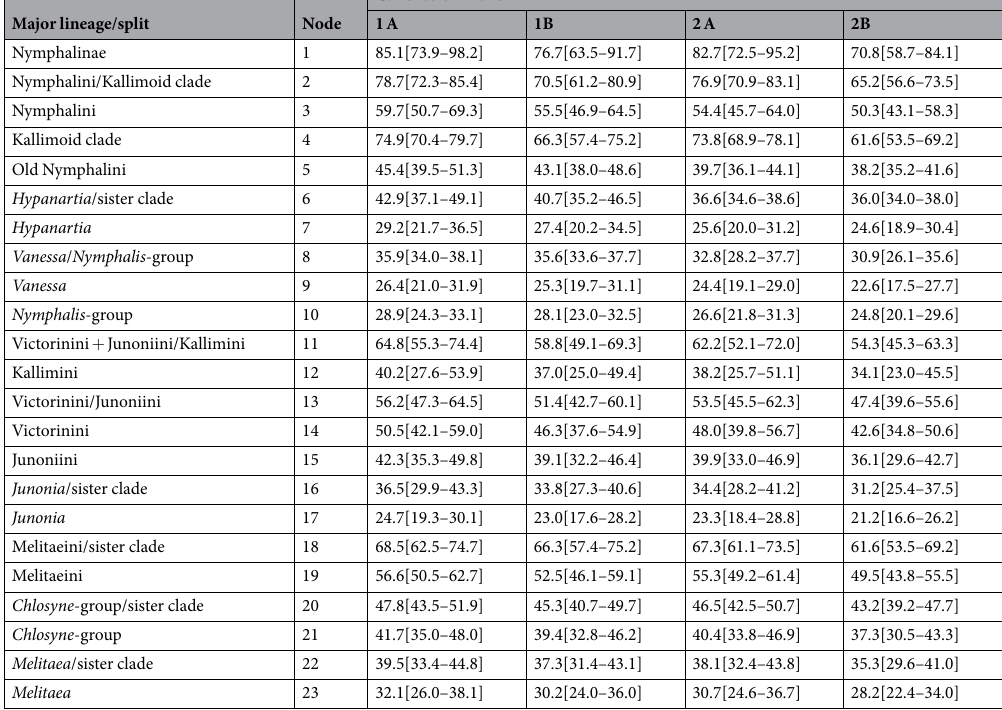
Table 1. Comparison of crown ages of major lineages and the most recent common ancestor (MRCA) of major splits in Nymphalinae across four different calibration stategies (1 A, 1B, 2 A, 2B; see under Methods). Notes: Numbers in brackets refer to 95% HPD intervals of clade ages (note that because HPD intervals are calculated from all trees, node ages occasionally fall outside the